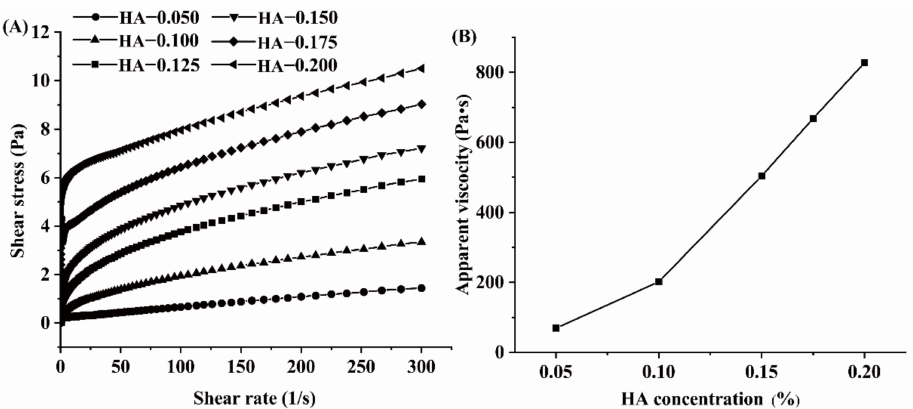
Figure 2. Relationship between shear stress and a shear rate of different HA concentrations of HA- β - carotene emulsion ( A ); effect of different HA concentrations of HA- β -carotene emulsion on mean apparent viscosity when the shear rate is 100 s − 1 ( B